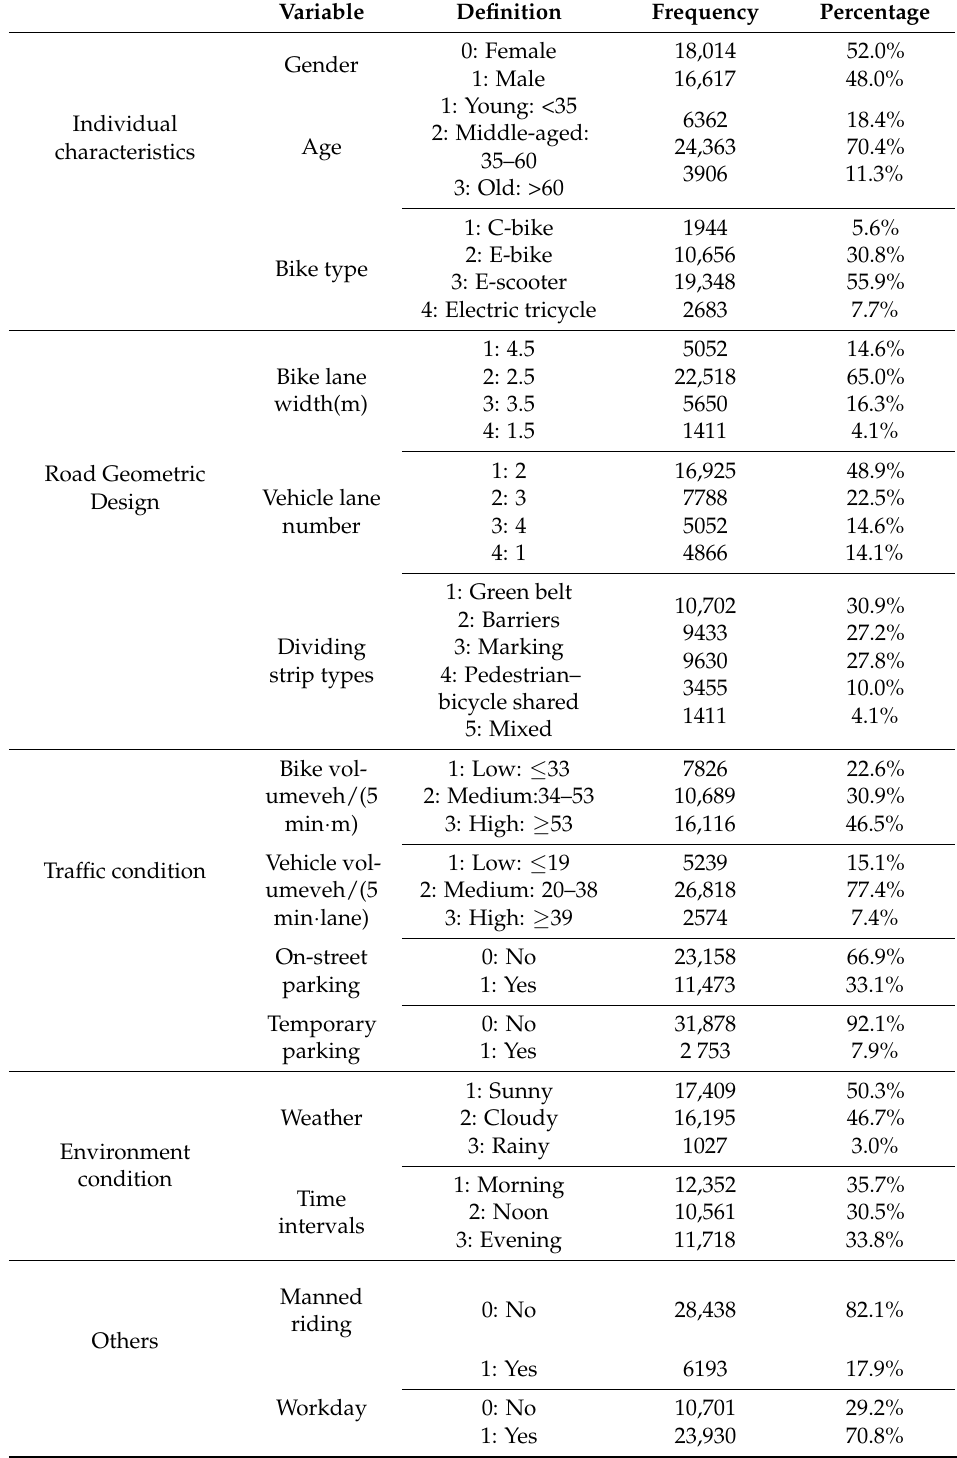
Table 2. Descriptive statics of explanatory